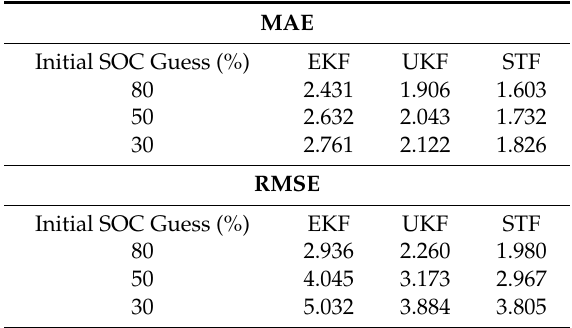
Figure 15. The robustness results for three algorithms: ( a ) EKF; ( b ) UKF; ( c ) STF. Table 5. The MAE and RMSE by EKF, UKF, and STF at 0 °C.